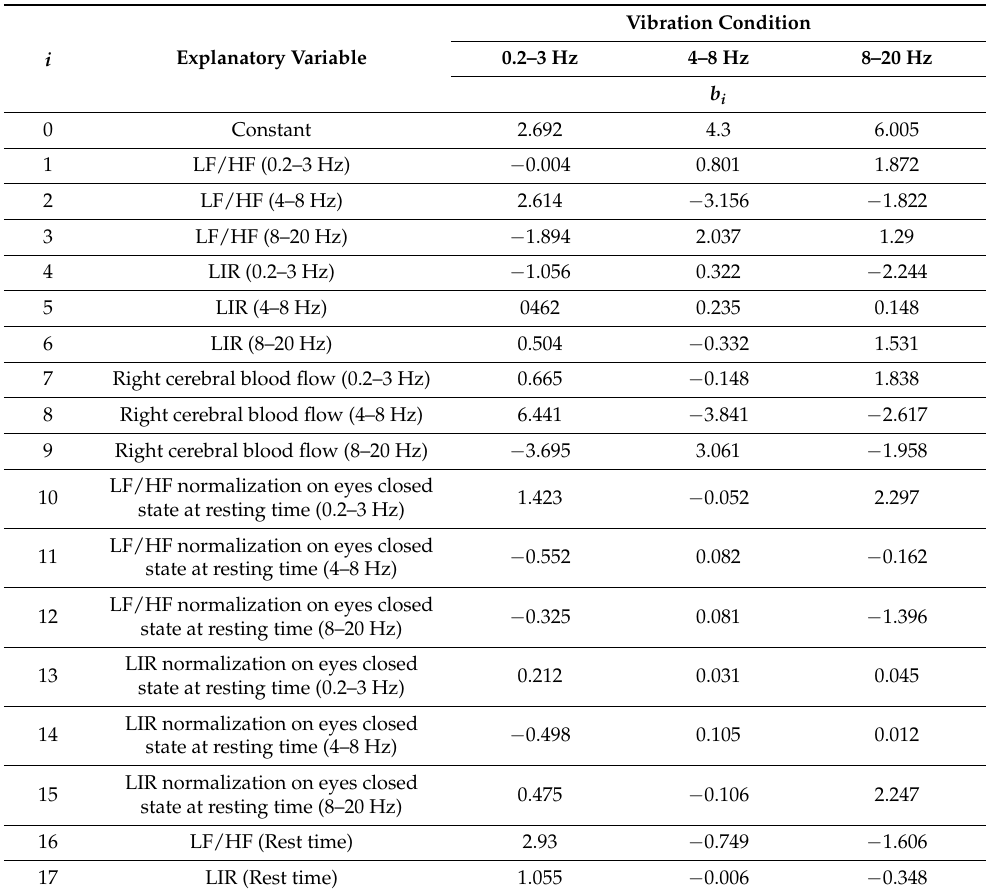
Table 1. Explanatory variables and their